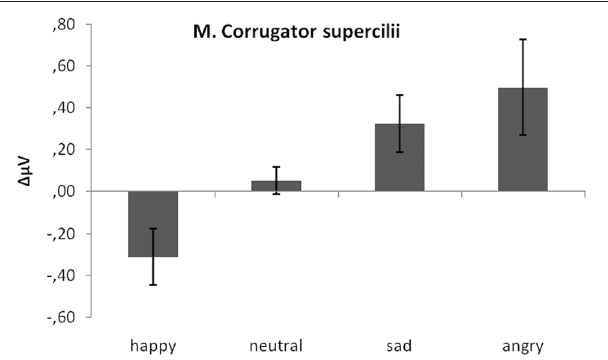
FIGURE 4 | Mean EMG change from baseline in µ V for M. corrugator supercilii in response to happy, neutral, and sad faces. Error bars indicate standard errors of the